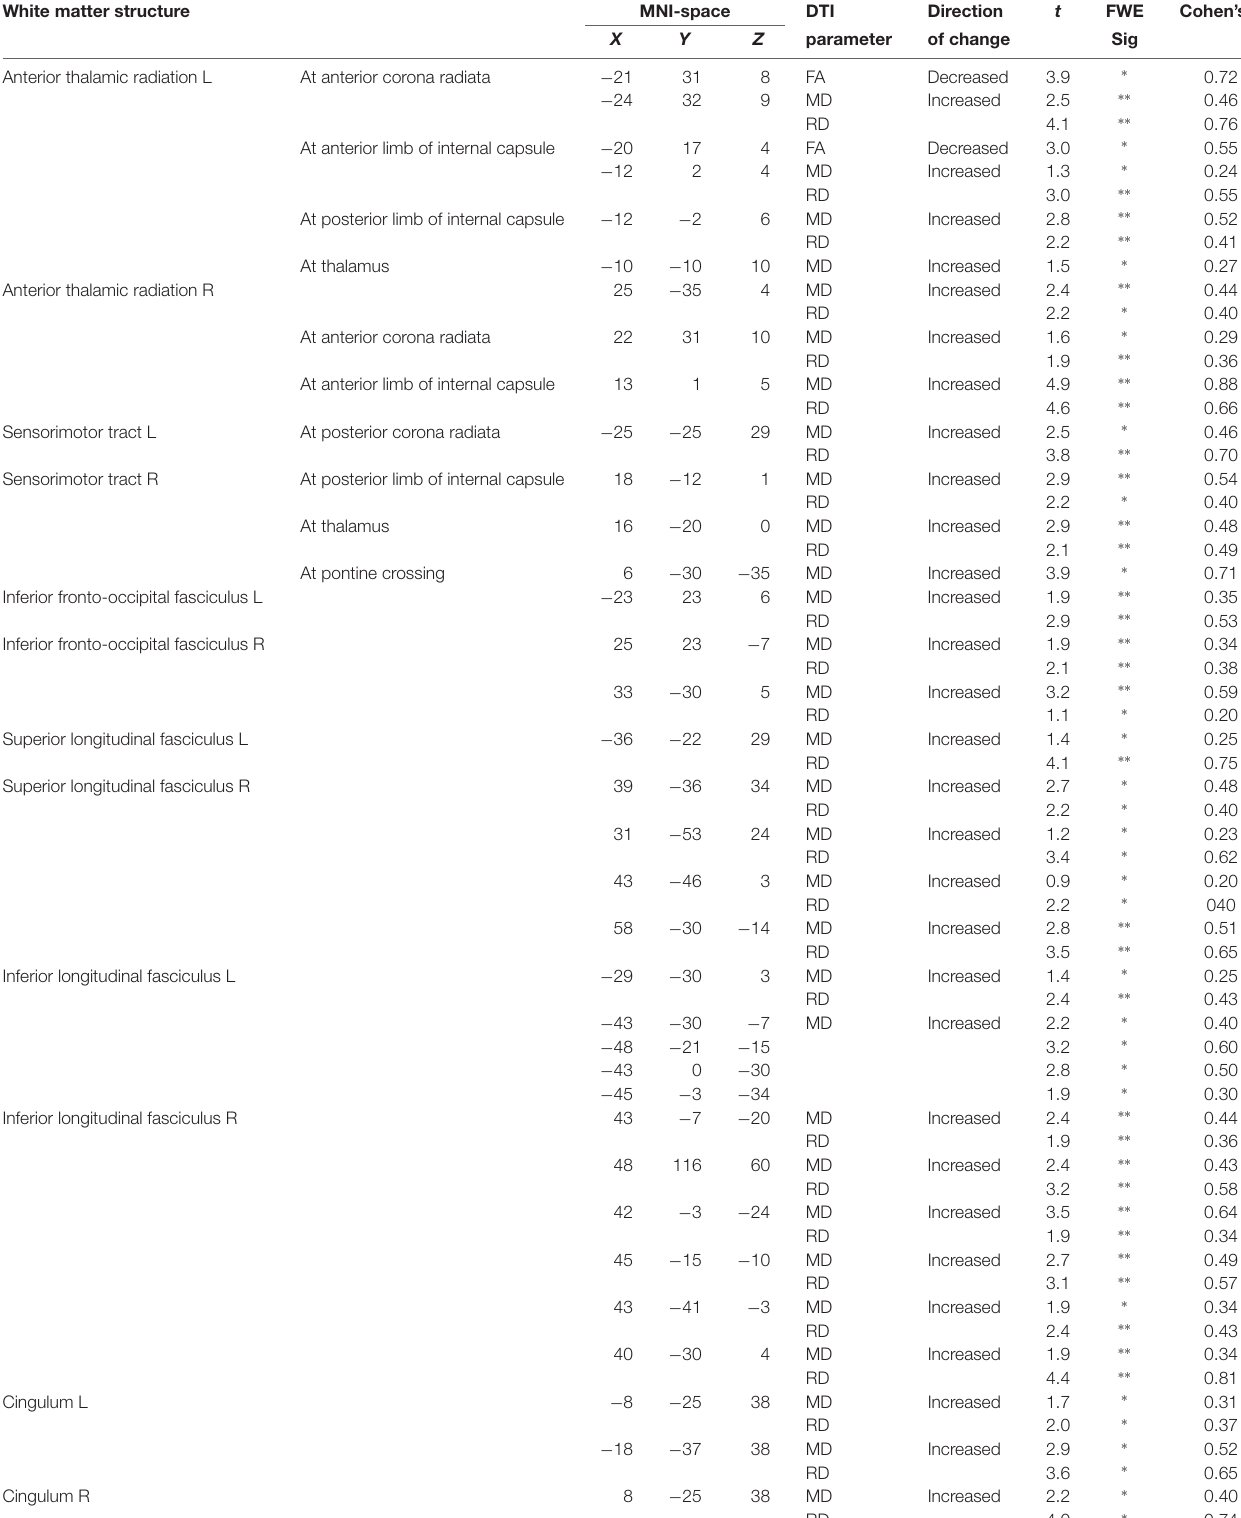
TABLE 3 | Effect of maturation on DTI parameters in children with DCD a . White matter structure